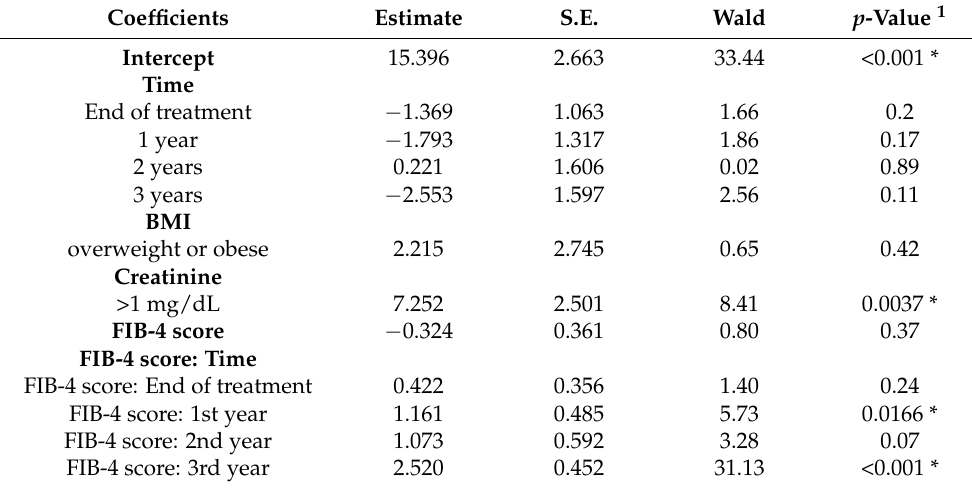
Table 4. Association of ASCVD and FIB-4 scores over follow-up time points (N =